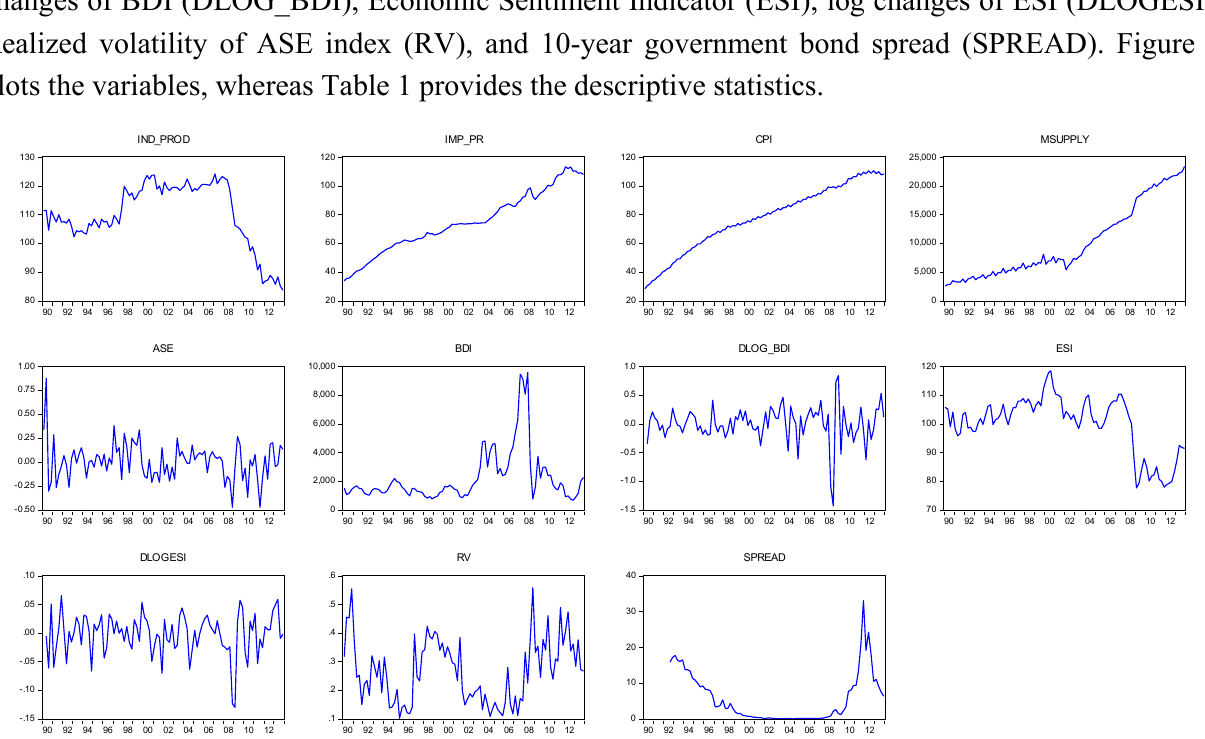
Figure 1. The explanatory variables: industrial production, import prices, CPI, money supply, Athens stock exchange (ASE) index, Baltic Dry Cargo Index (BDI), log changes of BDI, Economic Sentiment Indicator, log changes of ESI, Realized volatility of ASE index, and 10-year government bond spread. The sample period runs from 1990q1 to